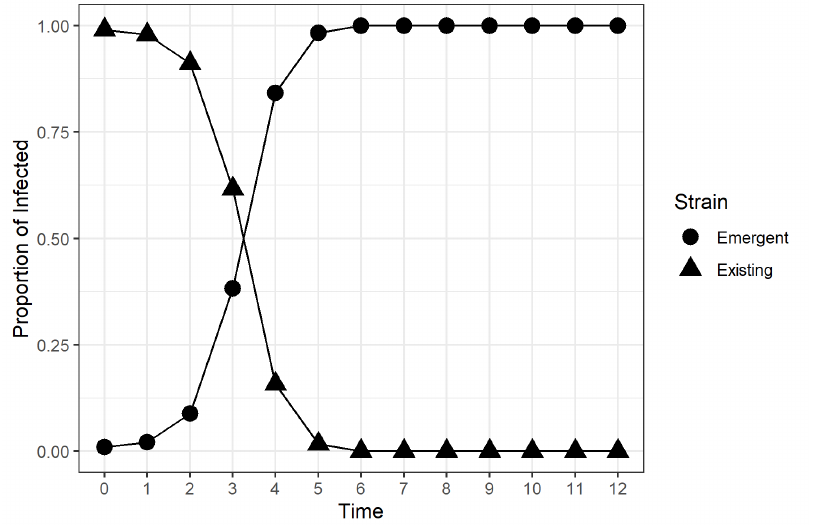
Figure 2. A representative simulation run for the factor combination ( β , β (cid:48) / β , ν , v ( 0 ) ) = (1.4, 1.5, 0.5, 0.25). The proportion of emergent strain infections follows a logistic growth